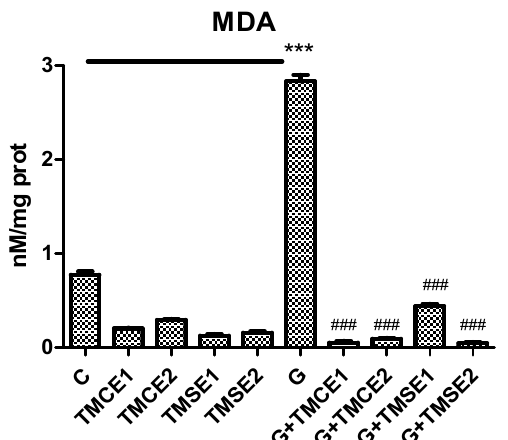
Figure 3. Malondialdehyde (MDA) levels in HUVECs after exposure to hyperglycemia and normoglycemia and after treatment with two different doses of TMCE and TMSE. Exposure to hyperglycemia (G) significantly increased MDA levels in cell lysates ( p < 0.001) compared to the control while TMCE and TMSE in both concentrations reduced MDA formation ( p < 0.001). Statistical significance of the difference between control groups and the ones treated with samples was evaluated with two-way ANOVA and Bonferroni post-hoc test. *** p < 0.001 vs. control cells and ### p < 0.001 vs. cells exposed to hyperglycemia.